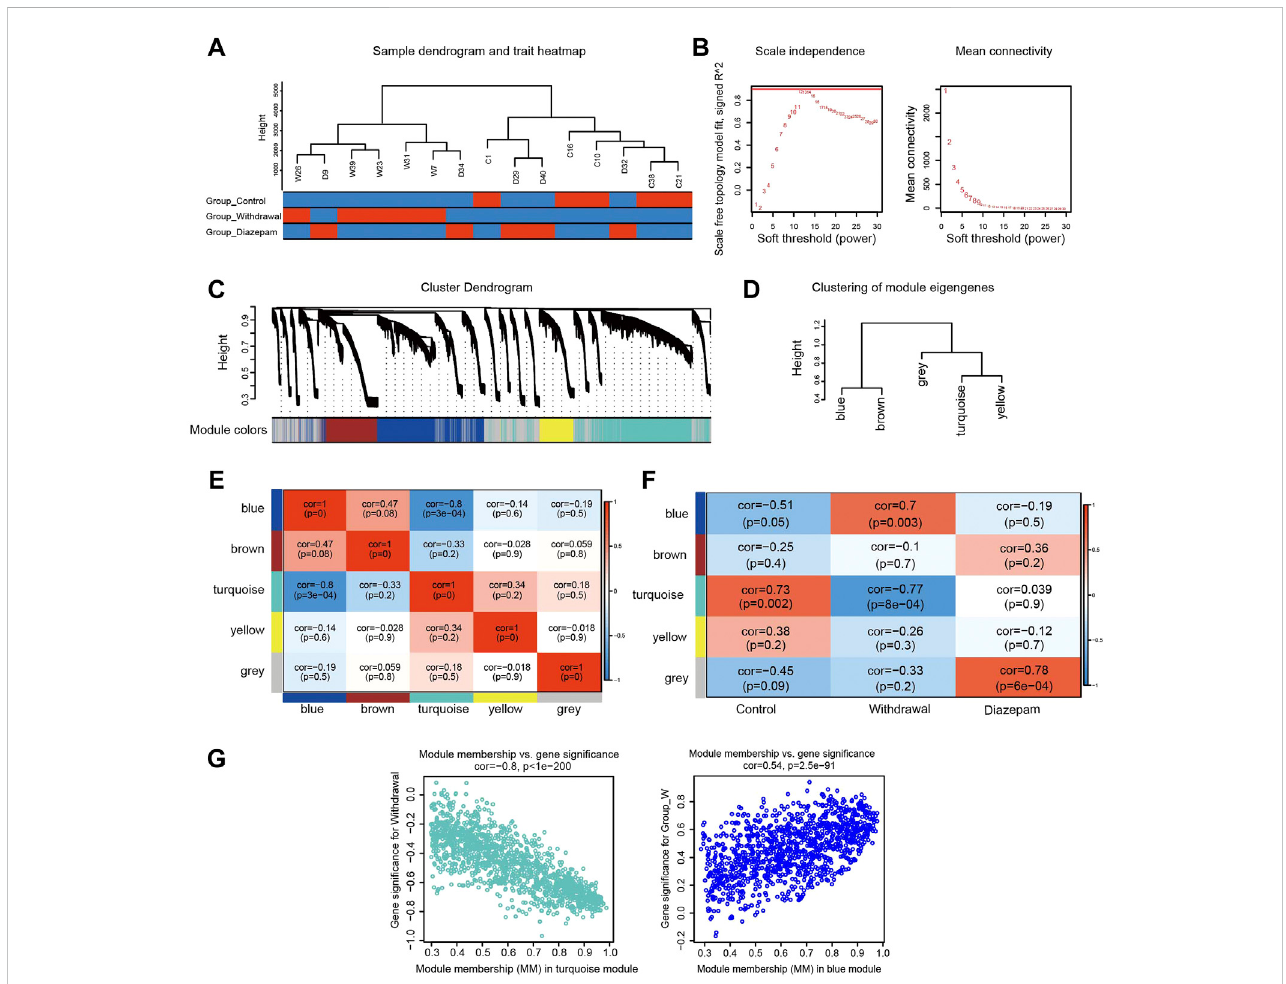
FIGURE 3 WGCNA identi fi ed modules associated with alcohol withdrawal. (A) Sample cluster dendrogram detected outliers and the trait heatmap displayed the sampletraits. (B) Soft-thresholding powerselectionofWGCNA. Theleftpanel showsthescale-free fi tindexasafunctionofthesoft-thresholdingpower.The right panel shows the mean connectivity as a function of soft-thresholding powers. (C) Module assignment and cluster dendrogram. Highly interconnected geneswereclustered and fi vemoduleswereidenti fi edwithhierarchicalclustering treeanalysis.Differentcolors representdifferentmodules. (D) Cluster dendrogram of fi ve modules. (E) Heatmap of the correlations among modules based on Pearson ’ s correlation coef fi cient. Correlation of the corresponding modules is represented by square colors. High correlation is represented with red, while low correlation is represented with blue. (F) The module – trait relationship heatmap. The columns represent Control, Withdrawal, and Diazepam Groups. The rows represent the module eigengenes. Corresponding correlations and p values are shown in each square. Blue represents a negative correlation, and red a positive correlation. (G) Scatterplot of genes in the turquoise and blue modules; the correlation and p -value are under the